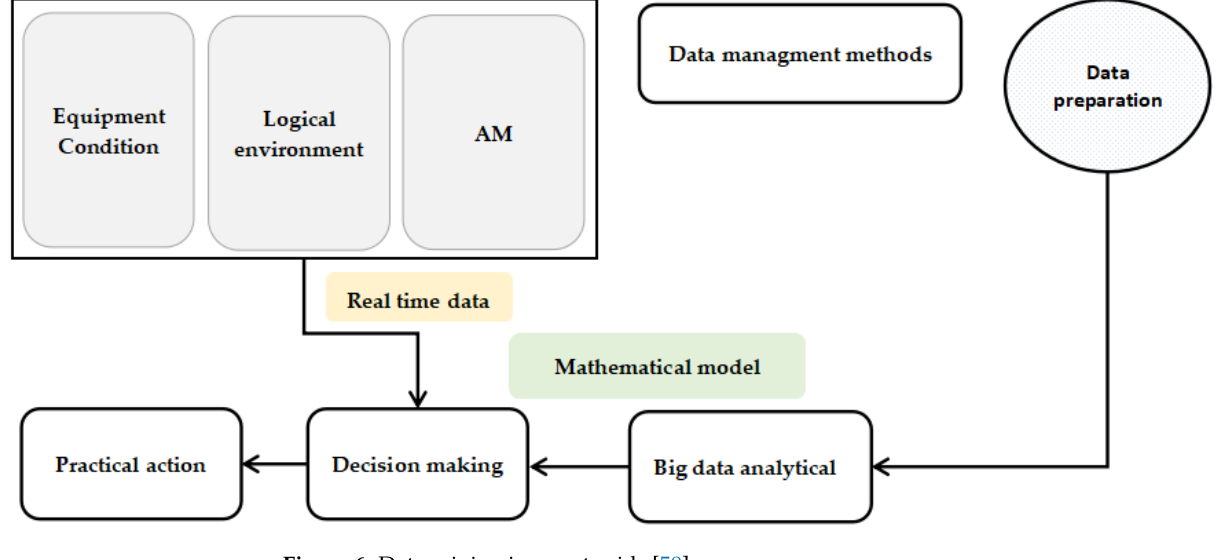
Figure 6. Data mining in smart grids [58].